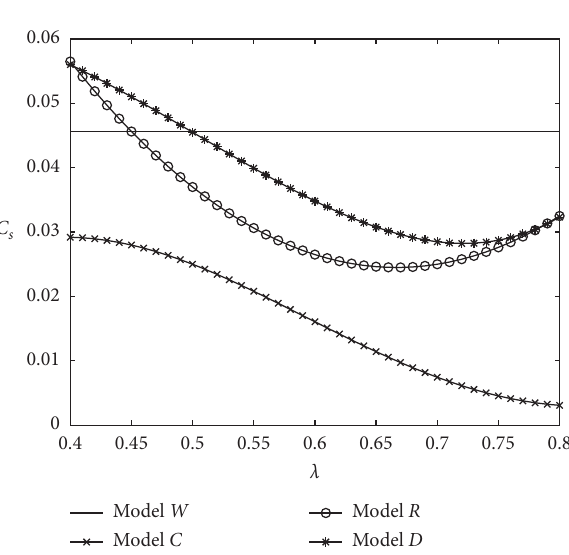
Figure 7: The impact of λ on consumer